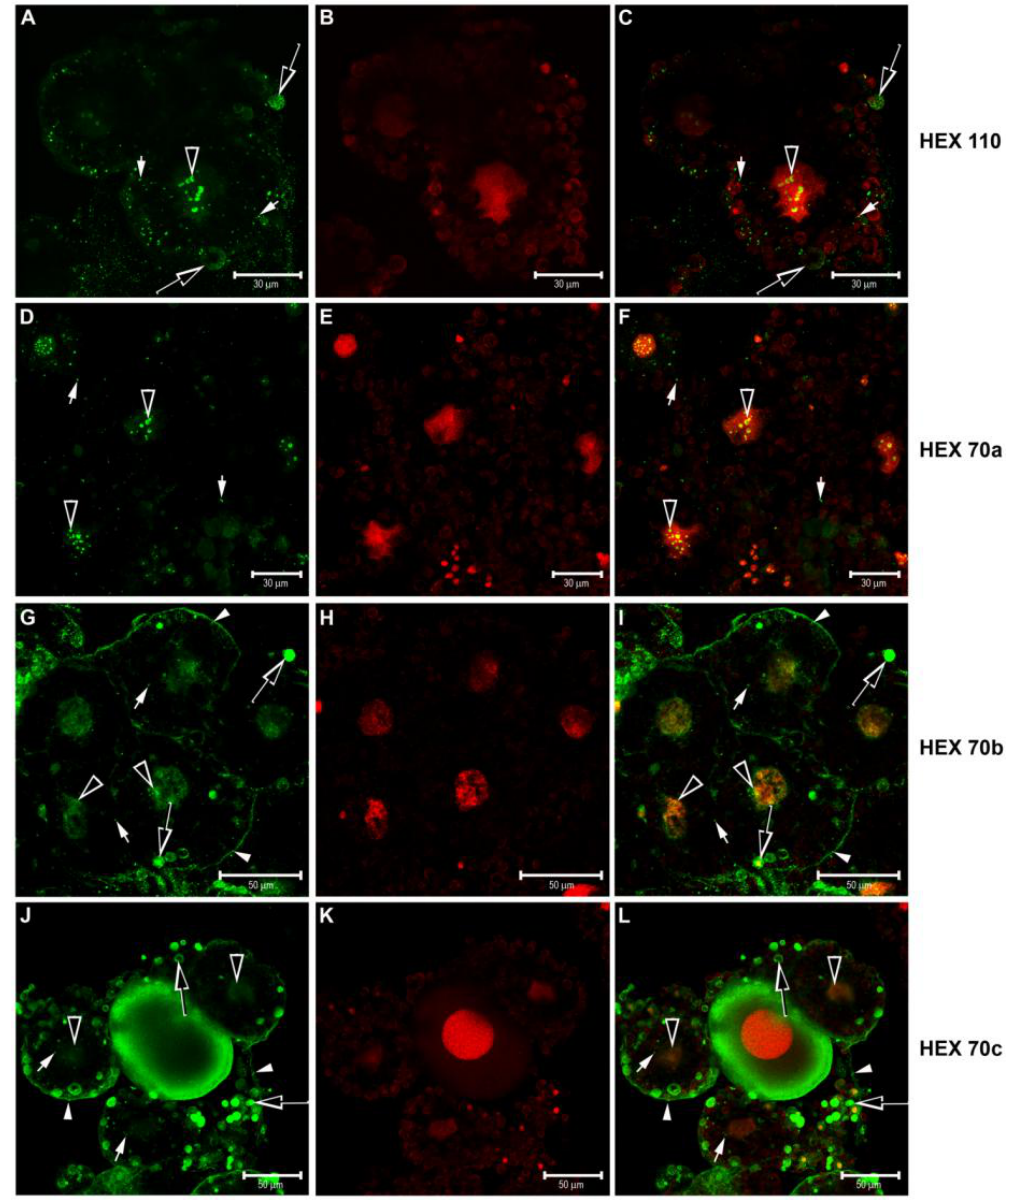
Figure 3. Confocal microscopy for detection of hexamerins in the trophocytes of pharate pupae (PP phase). Alexa Fluor 488-stained trophocytes: preparations with ( A ) anti-HEX 110, ( D ) anti-HEX 70a, ( G ) anti-HEX 70b and ( J ) anti-HEX 70c for detection of the respective hexamerins (green foci). ( B , E , H , K ) Propidium iodide-stained cell nuclei (red). At the right column, the merged images show: ( C ) HEX 110, ( F ) HEX 70a, ( I ) HEX 70b and ( L ) HEX 70c in the nuclei (yellow foci) and in the cytoplasm (green foci). Large hollowed arrowheads: nuclear foci of hexamerins. Small arrowheads: hexamerins in small granules near the cell surface. Large hollowed arrows: hexamerins in large cytoplasm granules. Small arrows: hexamerins in small cytoplasm granules. The cell in the center of Figures J, K and L is an oenocyte. The profusion of red inclusions in the trophocyte cytoplasm ( B , E , K ) are propidium iodide stained nucleic acids (DNA/ribosomal RNA), apparently derived from remnants of sequestered in autophagic